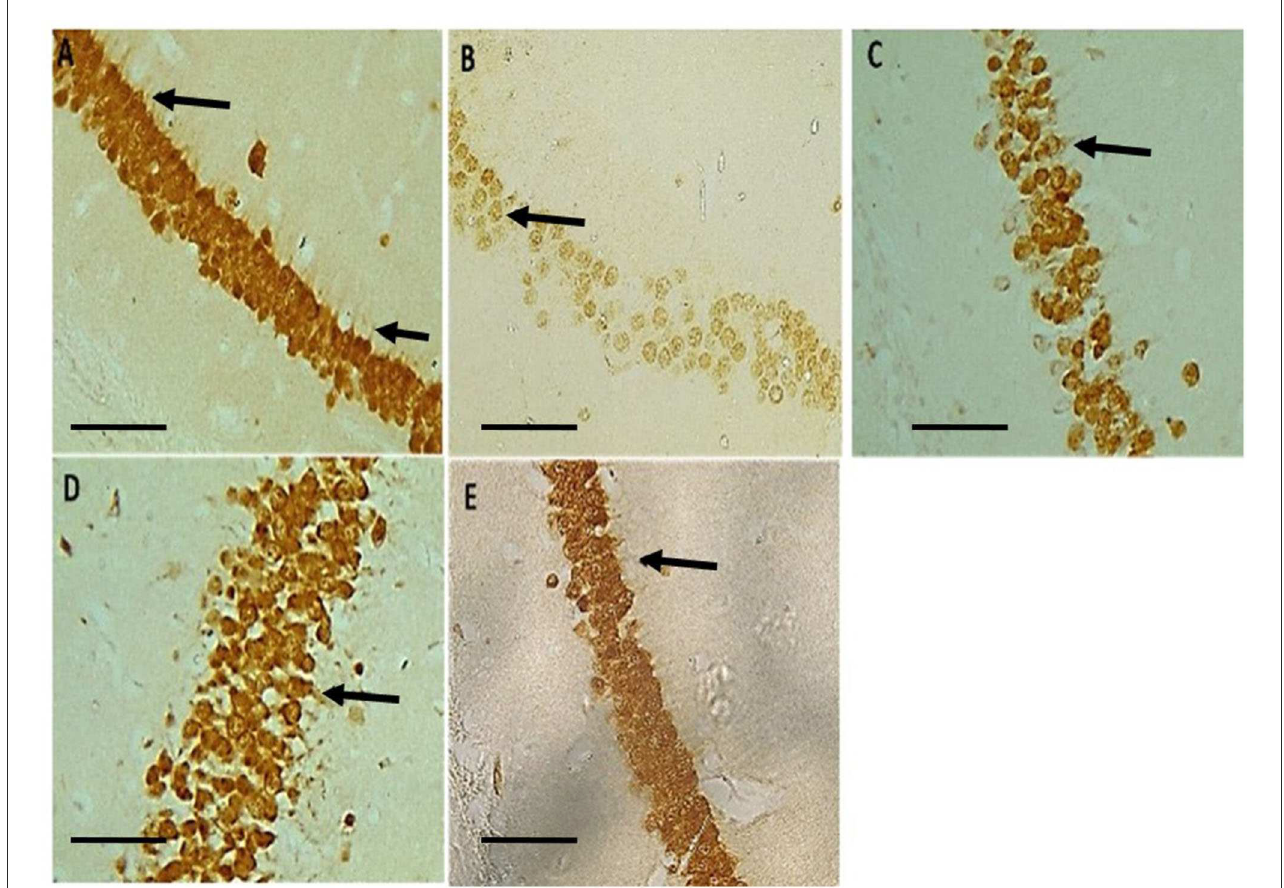
FIGURE6 Photomicrograph of Neu-N immuno-stained CA1 region of the hippocampus of control and experimental mice revealing a loss in apical dendrites of the pyramidal cells (black arrows) in untreated hydrocephalus group relative to control and a gradual reversal attempt affected in the vanadium-treated groups. (A) Control, (B) untreated hydrocephalus, (C) hydrocephalus + low dose vanadium, (D) hydrocephalus + intermediate dose vanadium, and (E) hydrocephalus + high dose vanadium; (Scale bar, 4 µ